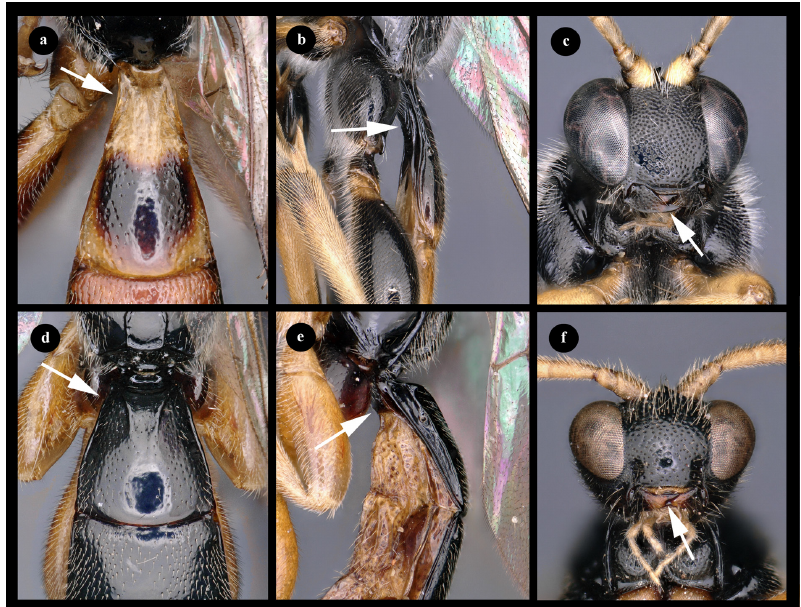
Fig. 6. a–c . Colpotrochia sp. a . Metasomal tergite 1, dorsal view. b . Metasomal tergite 1, lateral view. c . Head, antero-ventral view. d–f . Triclistus sp. d . Metasomal tergite 1, dorsal view. e . Metasomal tergite 1, lateral view. f . Head, antero-ventral view. Arrow in Fig. 6a points to metasoma petiolate anteriorly (compared to broad metasoma anteriorly in Fig. 6d). Arrow in Fig. 6b points to metasomal tergite 1 with long sternite (compared to metasomal tergite with short sternite in Fig. 6e). Arrow in Fig. 6c points to mandible with subequal teeth (compared to the mandible with shorter lower tooth in Fig.